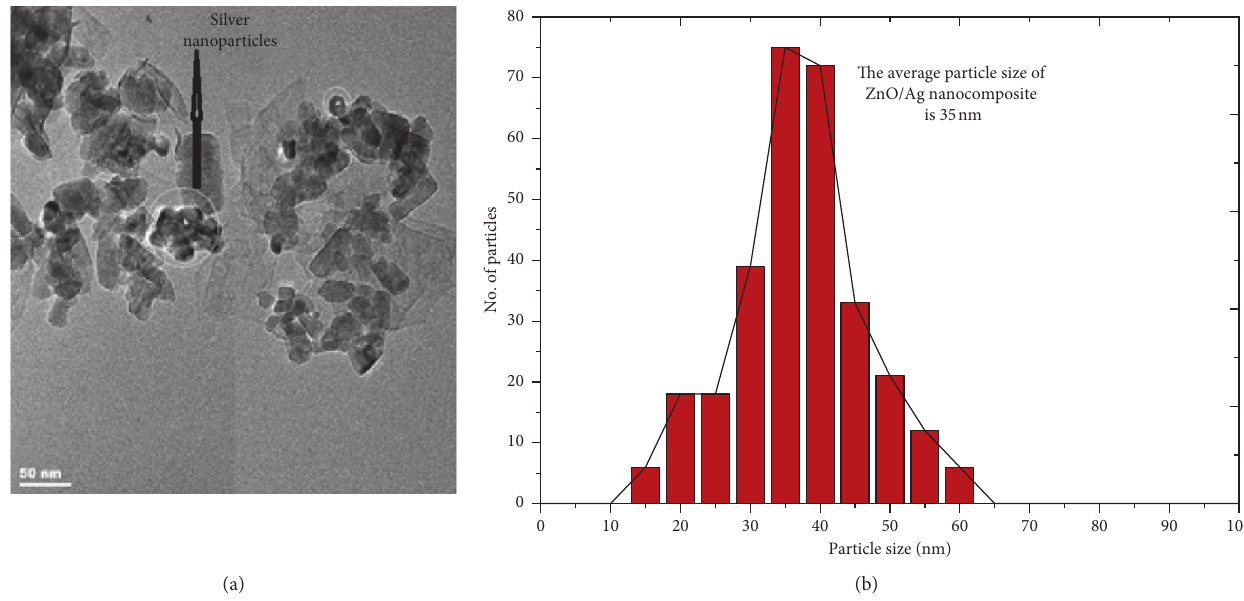
Figure 4: (a) TEM micrograph of ZnO/Ag. (b) Particle size distribution of ZnO/Ag